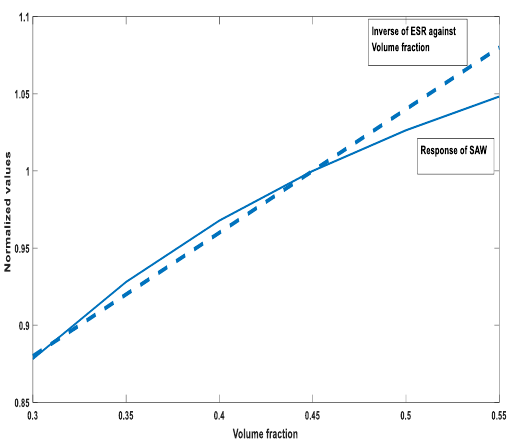
Fig.2: SAW Responses and ESR of the RBCs with different volume fractions.